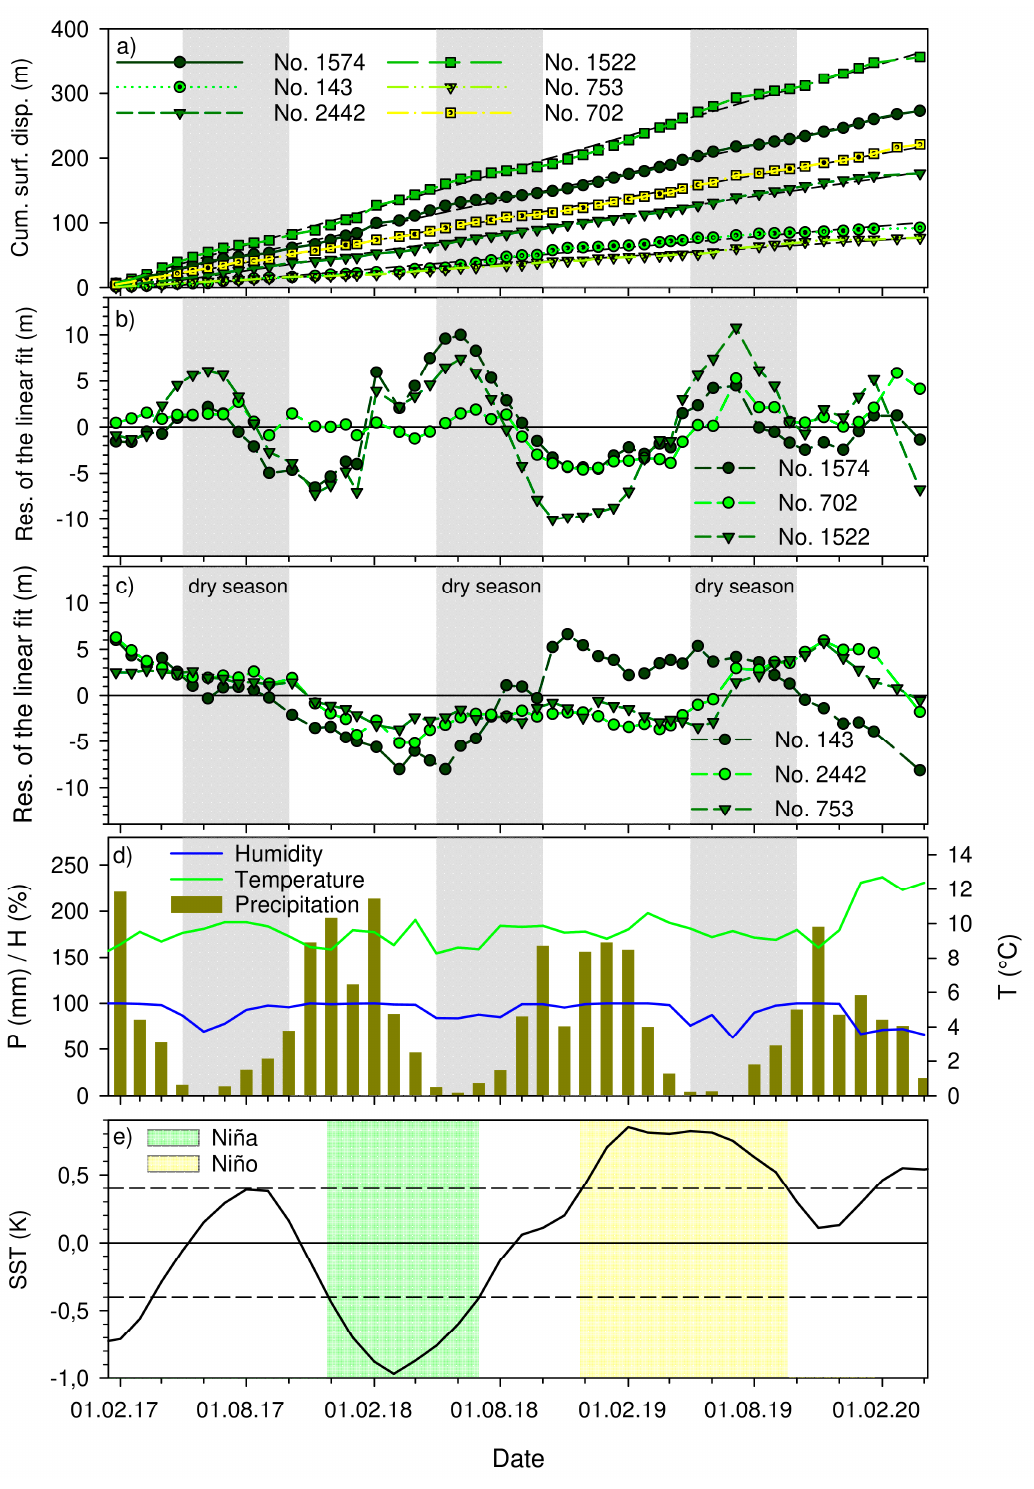
Figure 6. ( a ) Cumulative surface velocities from six representative points, ( b ) Residuals of the linear fit displaying an intra-annual (seasonal) pattern, from three representative points above 5500 m a.s.l. (No. 143), in the East (No. 2442), and West (No. 752) of the glacier, ( c ) Residuals of the linear fit displaying an inter-annual pattern, from three representative points for the glacier response in the central, south-exposed part of the glacier (Nos. 702, 1522, 1574), ( d ) meteorological data; Temperature T, Humidity H, Precipitation P (Palcacocha weather station, altitude 4607 m.a.s.l., latitude 09 ◦ 24 (cid:48) 09.3211”S, 77 ◦ 23 (cid:48) 07.0258”, Instituto Nacional de Investigaci ó n en Glaciares y Ecosistemas de Montaña INAIGEM), and ( e ) Sea Surface Temperature Anomalies (SSTA) shifted by 3 months (see main text) for the NOAA Niño 3.4